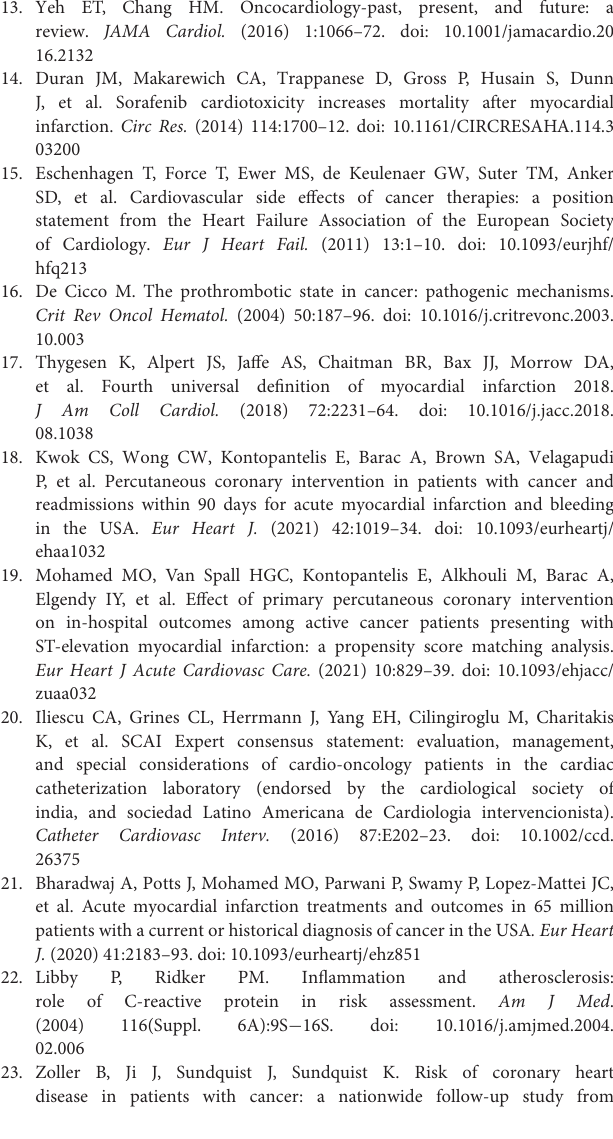
Supplementary Figure S1 | Clinical outcomes among AMI patients with and without cancer. Displayed are the cumulative incidence curves for (A) all-cause mortality, (B) MI, (C) stroke, and (D) revascularization for cancer patients vs. controls. AMI, acute myocardial infarction; MI, myocardial infarction. Supplementary Figure S2 | Subgroup stratified analysis of all-cause mortality among AMI patients with and without cancer. AMI, acute myocardial infarction;